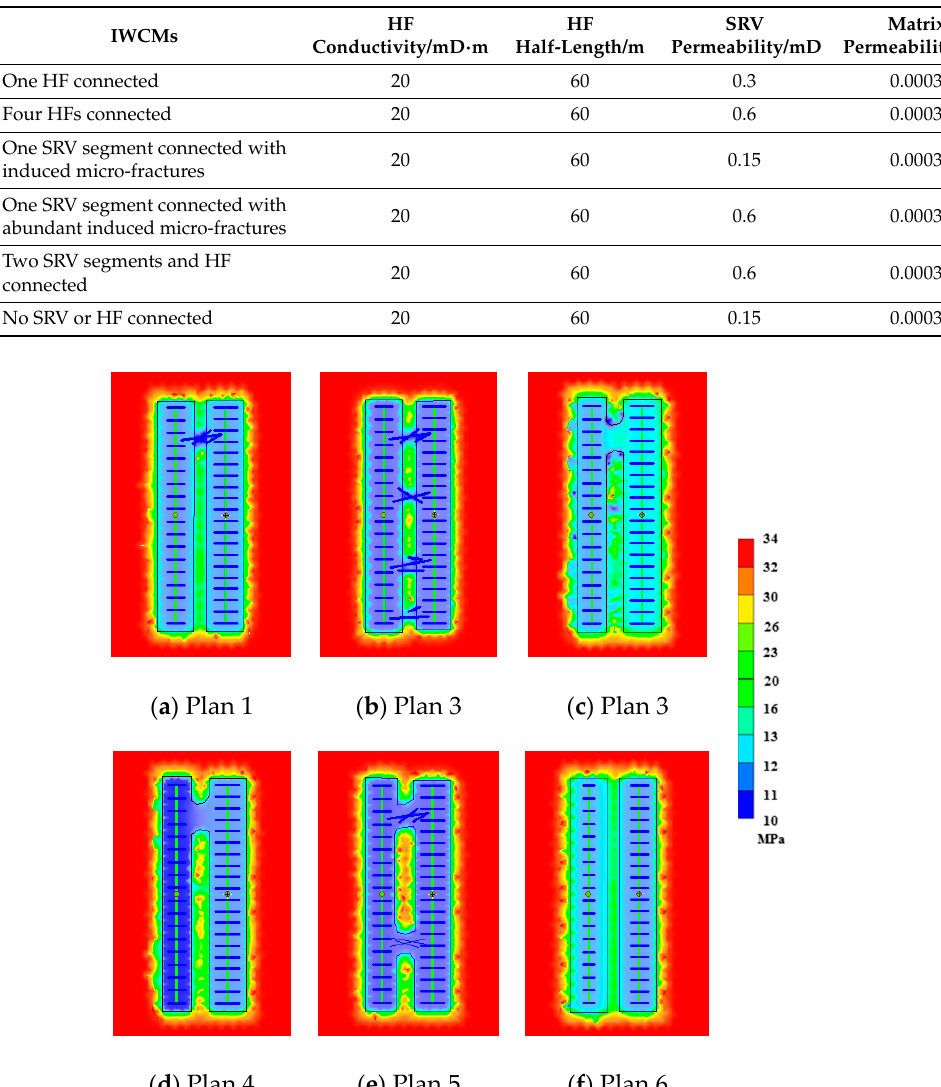
Figure 6. Pressure distribution after 15 months of simulated production of different plan. There are two wells in each plan, and L2 on the right is the investigated well, while L1 on the left is the neighboring well.